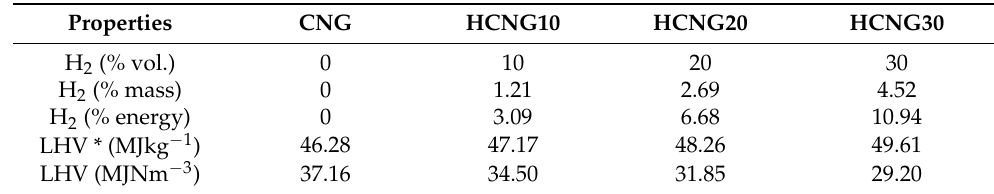
Table 2. Characteristics of CNG and HCNG mixtures with different hydrogen content (10%, 20% and 30%) (Reprinted from ref. [32]).